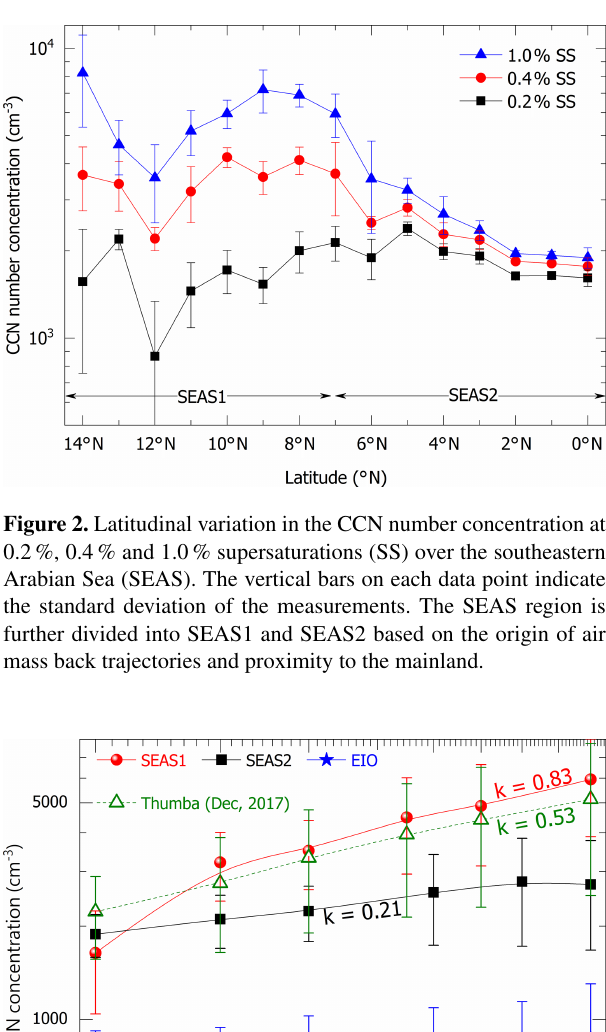
measurements above 8 ◦ N are modulated by the heteroge- neous sources located along the west coast of India. The CCN concentration at 1.0 % supersaturation was 5- to 7- fold higher than that at 0.2 % supersaturation over SEAS1, whereas the rate of change in CCN concentration with super- saturation is insignificant over